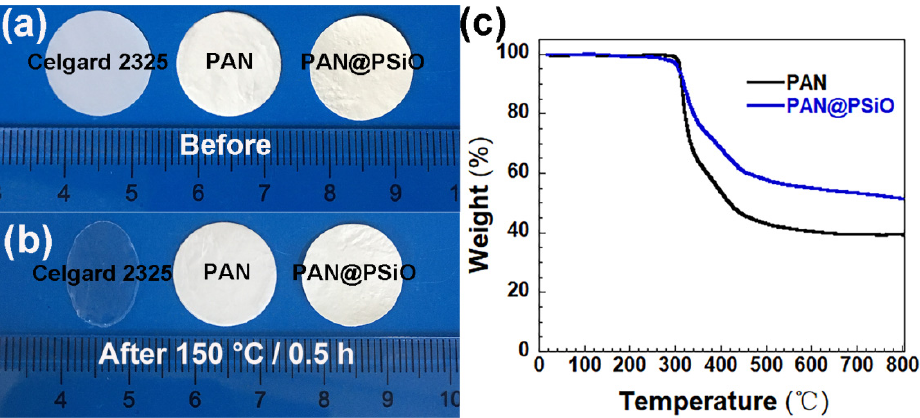
Figure 2. Optical photos of the Celgard 2325, PAN nanofiber membrane and PAN@PSiO nanofiber composite membrane ( a ) before and ( b ) after exposure at 150 °C for 0.5 h; ( c ) TGA curves of PAN and PAN@PSiO membranes.